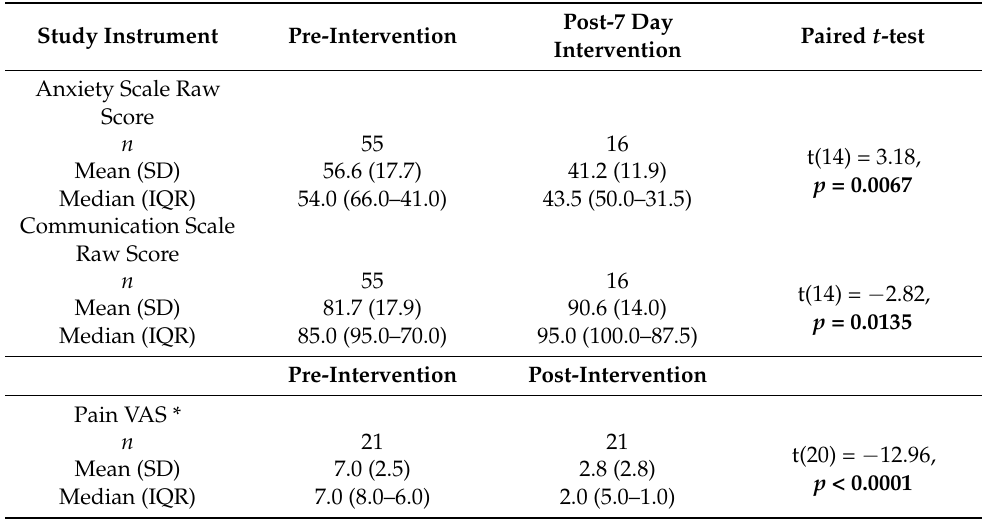
Table 4. Pre- and post-intervention anxiety and communication scale raw scores, and pain VAS